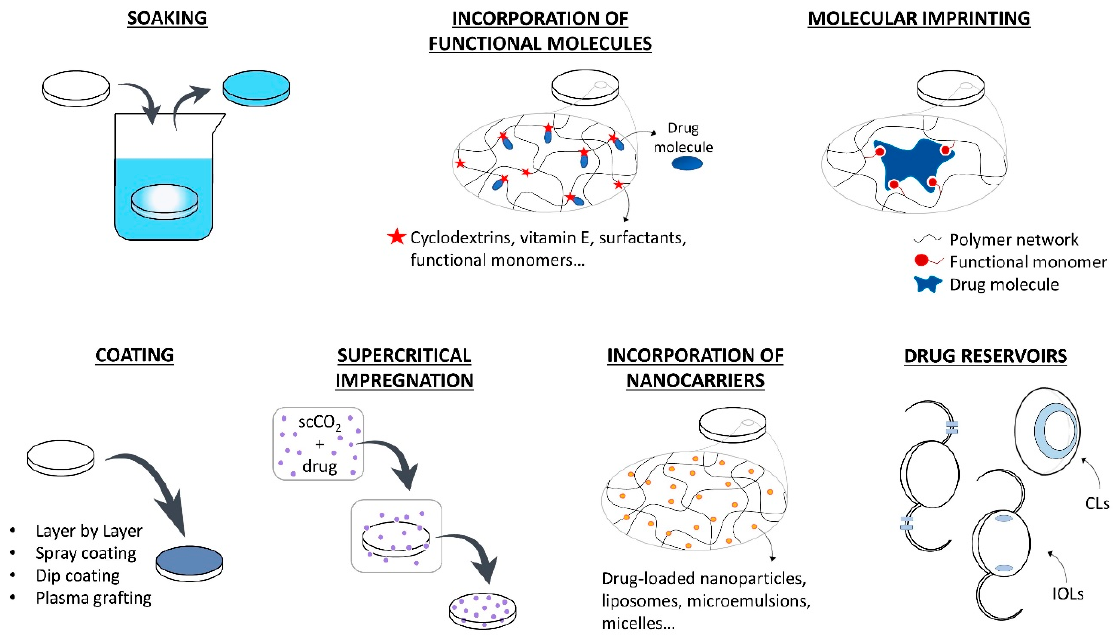
Figure 2. Strategies for the development of therapeutic ophthalmic lenses: soaking into a drug solution, incorporation of functional molecules with a high affinity to the drug, molecular imprinting, drug-eluting or drug-barrier coating, supercritical impregnation, incorporation of nanocarriers and incorporation of drug reservoirs.